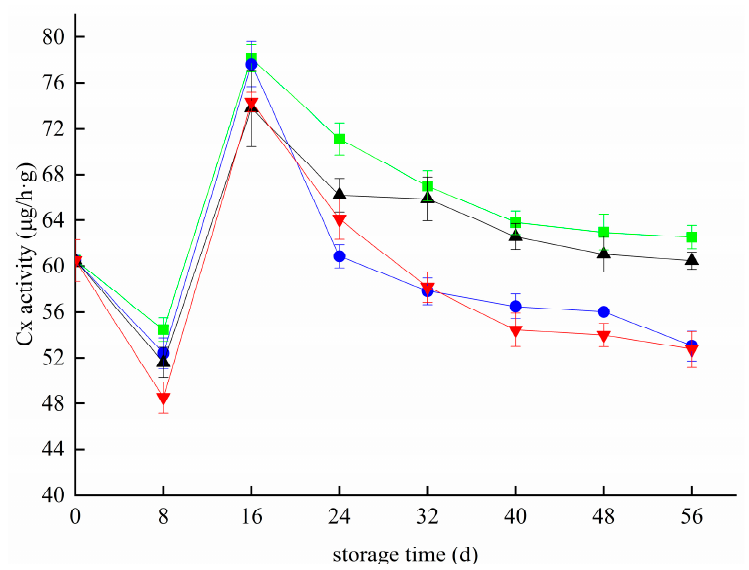
Figure 6. Effect of cellulase activity in blueberry under different treatments. ■ : control; ● : T; ▲ : Z: ▼ : T plus Z.